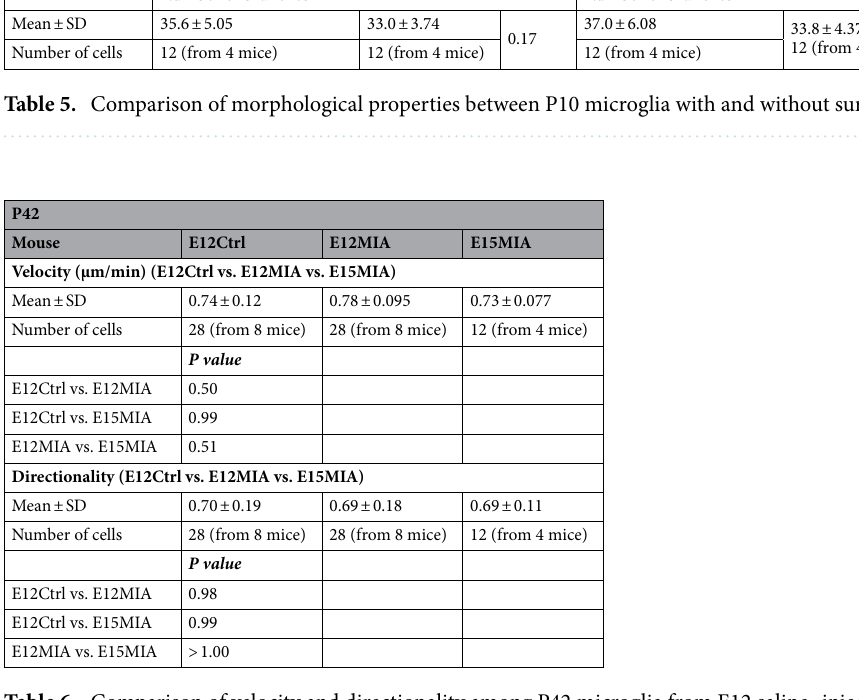
Table 6. Comparison of velocity and directionality among P42 microglia from E12 saline -injected, E12 Poly(I:C) -injected and E15 Poly(I:C) -injected mice before